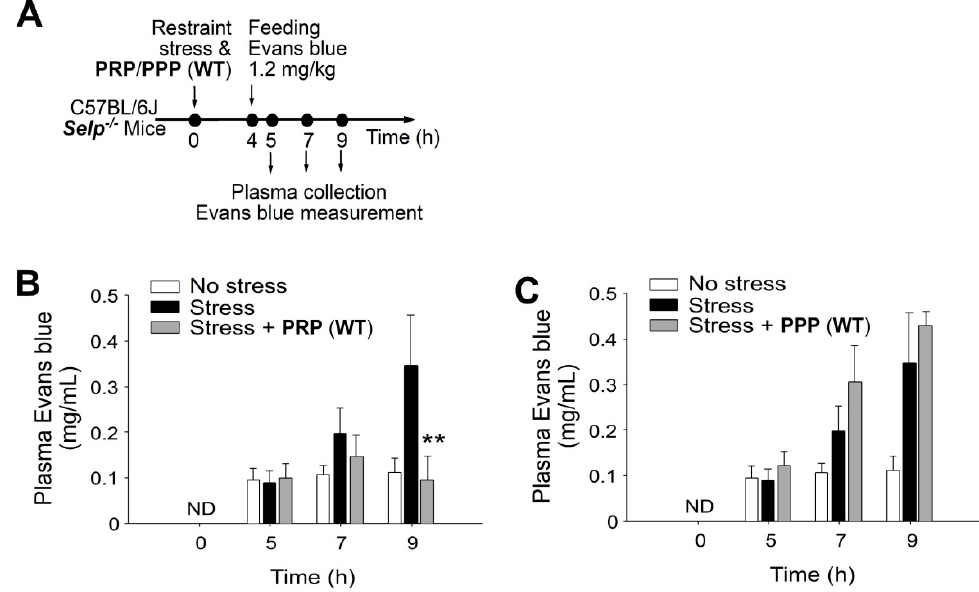
Figure 3. Wild-type (WT) mouse-derived platelet rich plasma (PRP) but not platelet-pool plasma (PPP) rescues stress-induced gut leakage in Selp − / − mice. ( A ) Experiment outline of restraint stress mouse model with Evans blue treatment. ( B ) Plasma Evans blue levels of Selp − / − mice without re- straint stress (no stress) and with stress (stress) and stress plus PRP (WT) rescue (stress + PRP) at 0, 5, 7, and 9 h. ND: not detected. ( C ) Plasma Evans blue levels of Selp − / − mice without restraint stress (no stress) and with stress (stress) and stress plus PPP (WT) rescue (stress + PPP) at 0, 5, 7, 9 h. ND: not detected. ** p < 0.01, vs. respective stress groups. n = 6 (three experiments with total six mice per group). Figure 4. Transfer of wild-type (WT) washed platelets rescues stress-induced gut leakage in P-selectin-deficient ( Selp − / − ) mice. ( A ) Experiment outline of restraint stress mouse model with Evans blue treatment. ( B ) Plasma Evans blue levels of Selp − / − mice without restraint stress (no stress) and with stress [stress ( Selp − / − )] and stressed Selp − / − mice transferred with wild-type plate- lets [stress ( Selp − / − ) + PLT (WT)] at 0, 5, 7, and 9 h. ND: not detected. ( C ) Plasma Evans blue levels of mice without restraint stress (no stress) and with stress (stress) and stressed wild-type mice transferred with platelets derived from Selp − / − mice [stress ( Selp − / − ) + PLT ( Selp − / − )] at 0, 5, 7, and 9